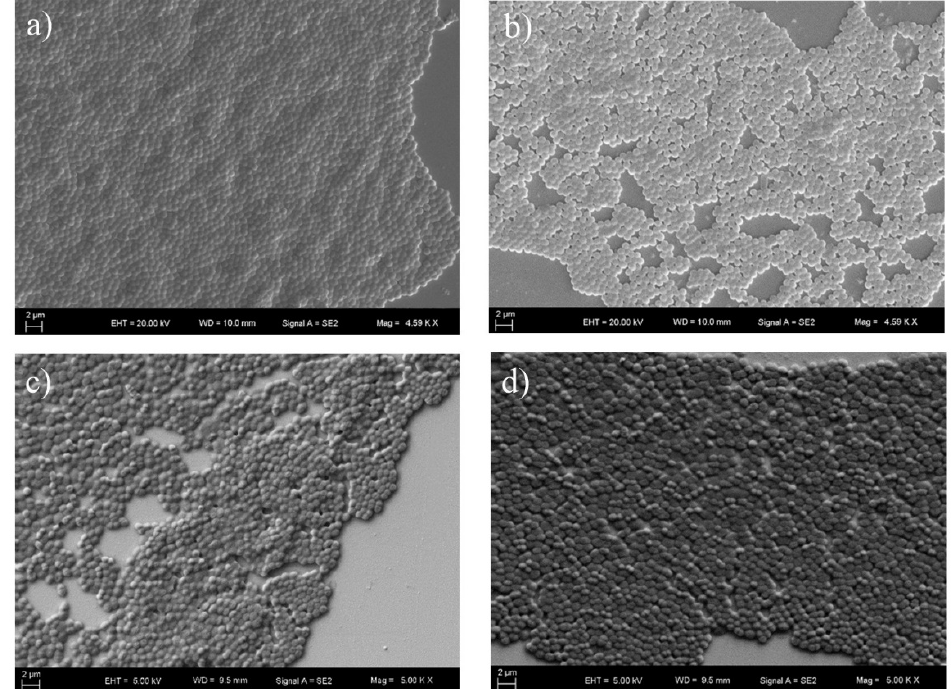
Figure 7. SEM micrographs of the bacteria without antibiotic treatment. ( a ) Methicillin-resistant S. aureus at 4.59 KX magnification; ( b ) methicillin-susceptible S. aureus at 4.59 KX magnification; ( c ) vancomycin-resistant enterococci at 5 KX magnification; ( d ) vancomycin-susceptible enterococci at 5 KX magnification.